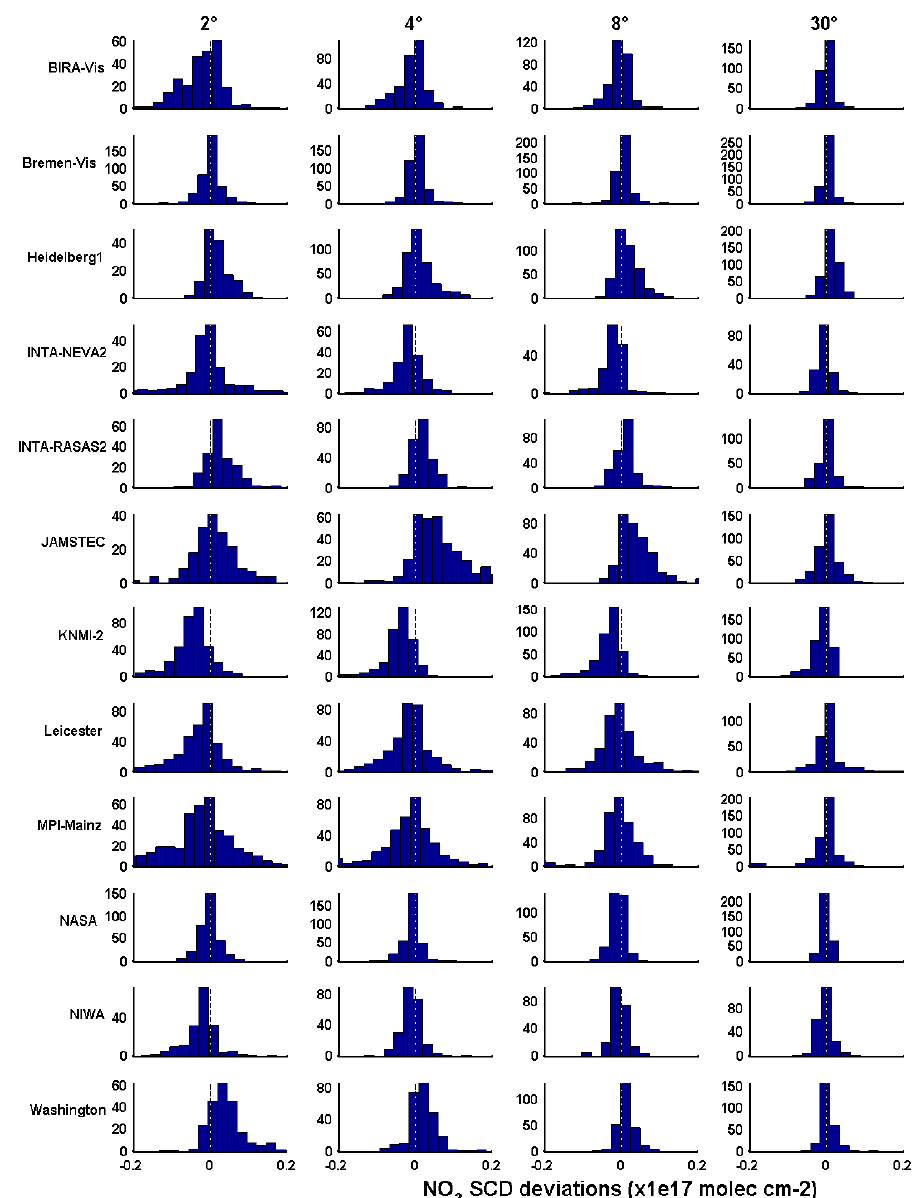
Fig. 9. Histograms of the absolute deviations of visible measurements from the reference visible data set, for the whole campaign.